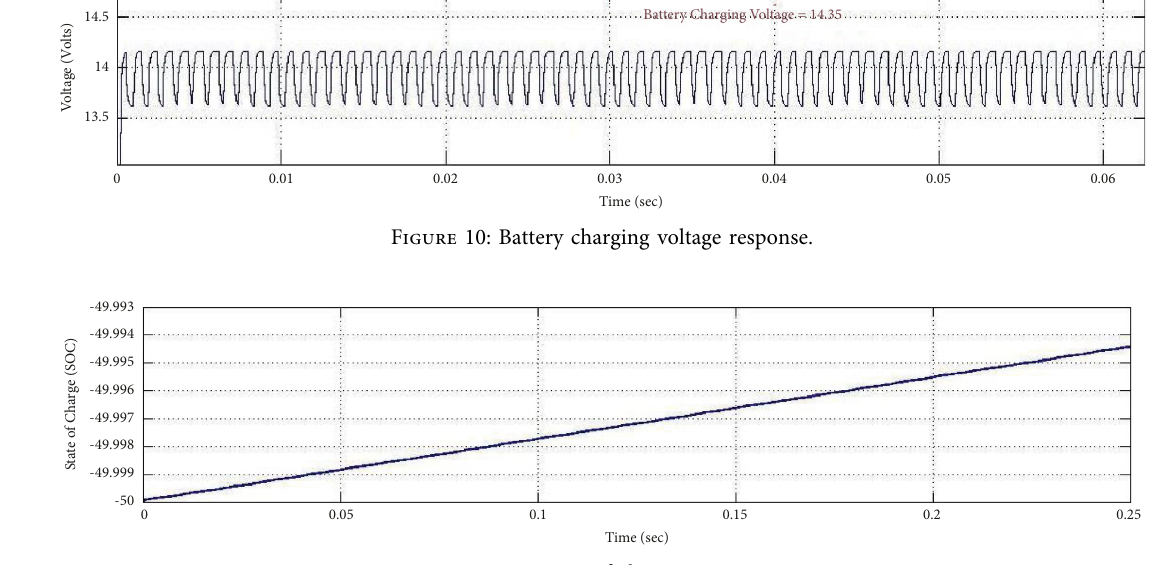
Figure 11: State of charge response.